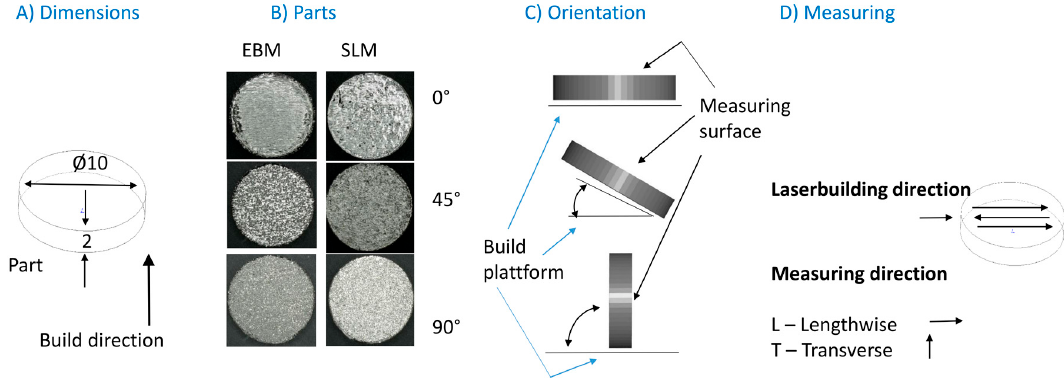
Figure 1. Design of the Ti6Al4V test specimens. ( A ) Specimens with dimensions (mm) as shown were built in three build orientations ( B , C ) using two manufacturing systems; surface measurement (Ra) was carried out in two directions (lengthwise and transverse) on the part surface ( D